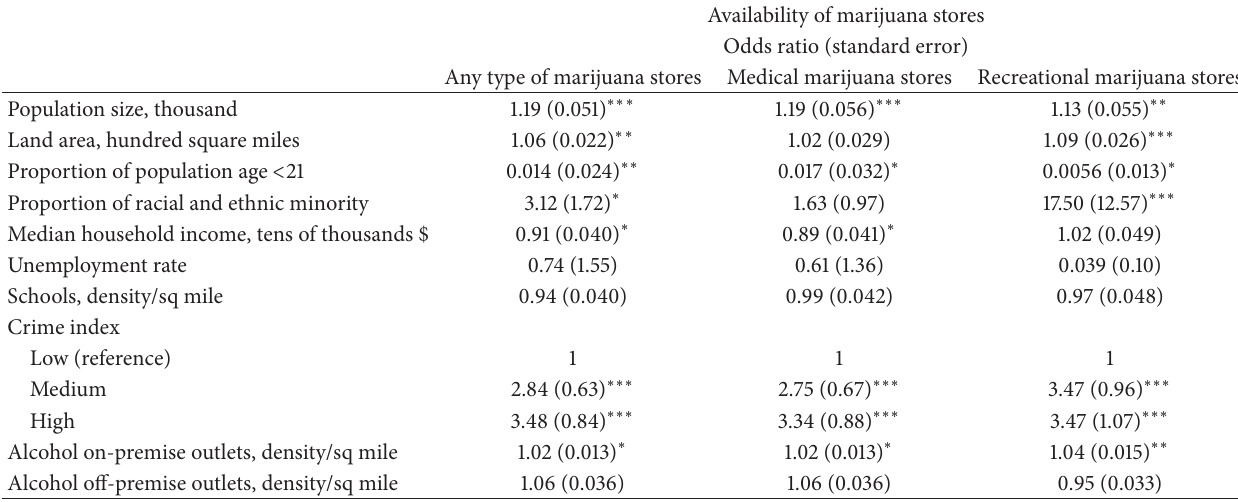
Table 3: Autologistic regression: availability of marijuana stores in Colorado and neighborhood